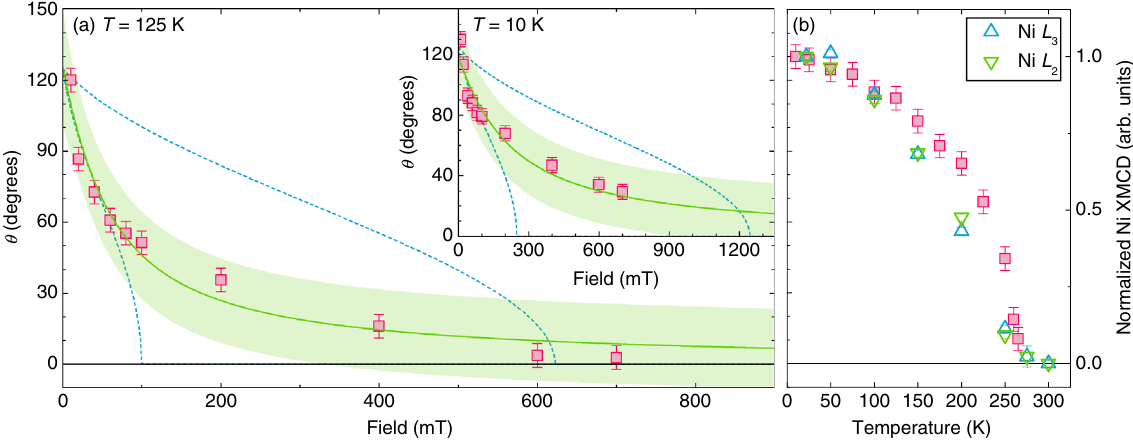
FIG. 5. Magnetic-field and temperature dependence of the coupling angle for the ½ð LaNiO 3 Þ 3 = ð La 2 Sr 1 MnO 3 Þ 9 (cid:3) 14 superlattice = 3 = 3 on LSAT. (a) Evolution of the coupling angle with an in-plane field applied along the (100) direction at 125 K (a) and 10 K (inset). ¼ 1 The solid line shows the best fit to Eq. (3) with J ¼ 3 . 4 × 10 − 5 J m − 2 at 125 K and J ¼ 1 . 2 × 10 − 4 J m − 2 at 10 K, assuming S Ni at both temperatures. Shaded regions represent the 95% prediction interval using Eq. (3). Dashed lines show the expected behavior ¼ − 1 . 00 × 10 − 4 J m − 2 and J ¼ − 8 . 75 × 10 − 5 J m − 2 (upper curve, main within the bilinear-biquadratic model [Eq. (1)] for J BL BQ ¼ − 1 . 60 × 10 − 5 J m − 2 and J ¼ − 1 . 40 × 10 − 5 J m − 2 (lower curve, main panel), J ¼ − 2 . 00 × 10 − 4 J m − 2 and panel), J BL BQ BL (b) Variation of the coupling angle with temperature in an applied field of 1.2 mT. Error bars ð(cid:2) 5 ° Þ indicate the estimated uncertainty in fitting of the PNR spectra, and they are greater than the errors that arise from counting